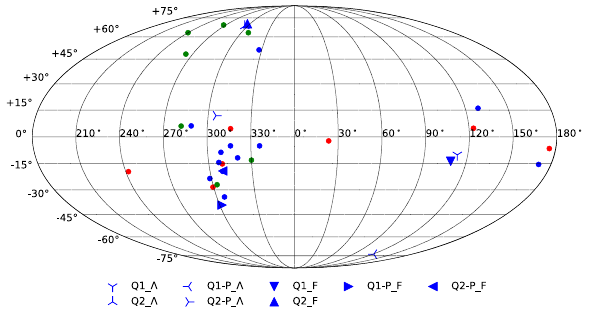
Fig. 6 The distributions of preferred directions derived from different samples in the galactic coordinate system. The blue markers indicate preferred directions obtained by the DF method. The red markers indi- catepreferreddirectionsobtainedbytheHCmethod.Thegreenmarkers indicate the other preferred directions. (cid:2) indicates the directions in the dipole-modulated (cid:2) CDM model and F indicates the directions in the Finslerian cosmological